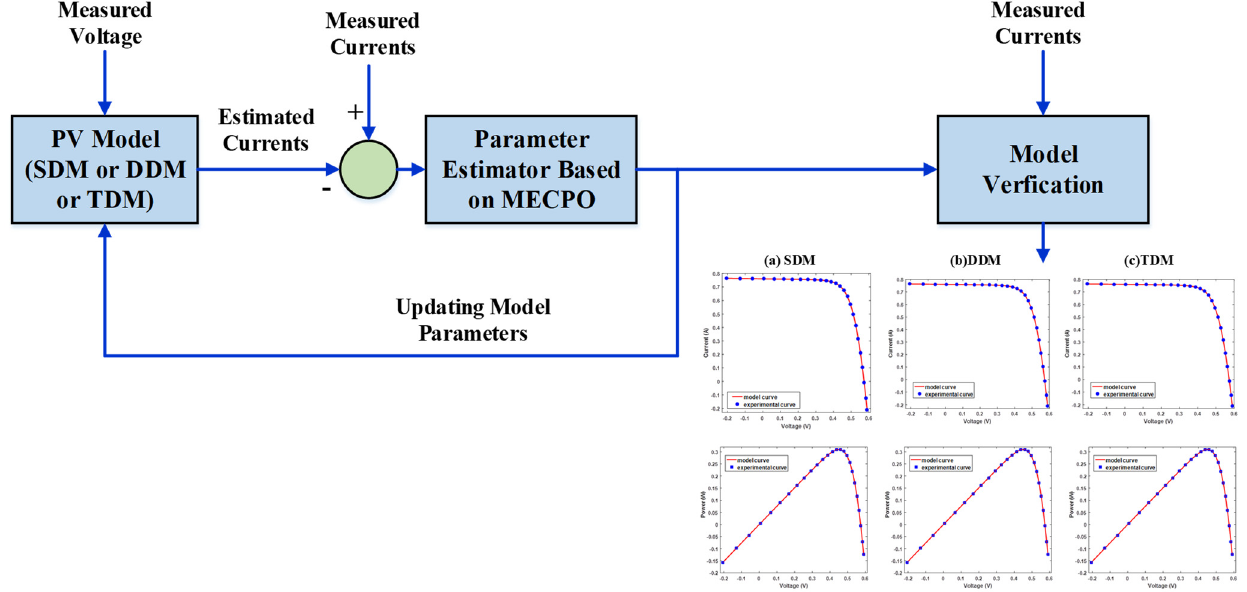
Figure 7. Global parameter estimation representation based on MECPO optimization algorithm. Table 5. Parameter settings of the selected techniques.